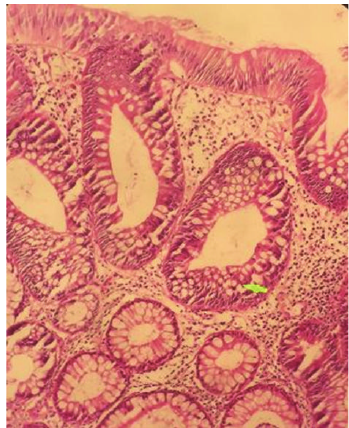
Figure 3: Pathological examination of the polyps confirmed adeno- matous and hamartomatous polyps (tubular type), with low grade dysplasia (H&E